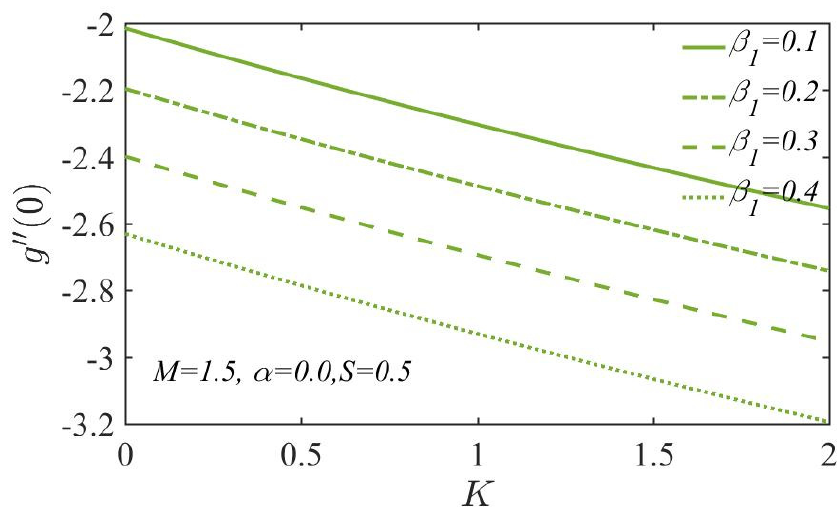
Figure 14. Concentration magnitude for (cid:1837) (cid:3030) < 0 .